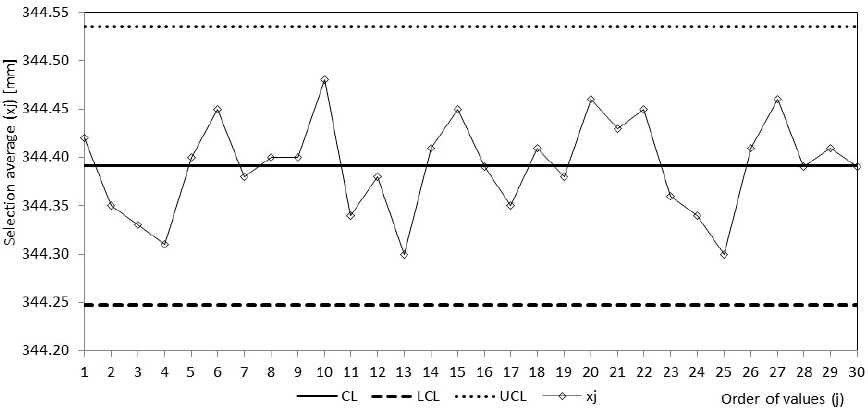
Figure 22. Shewhart control chart for individual values, parameter length, 3rd